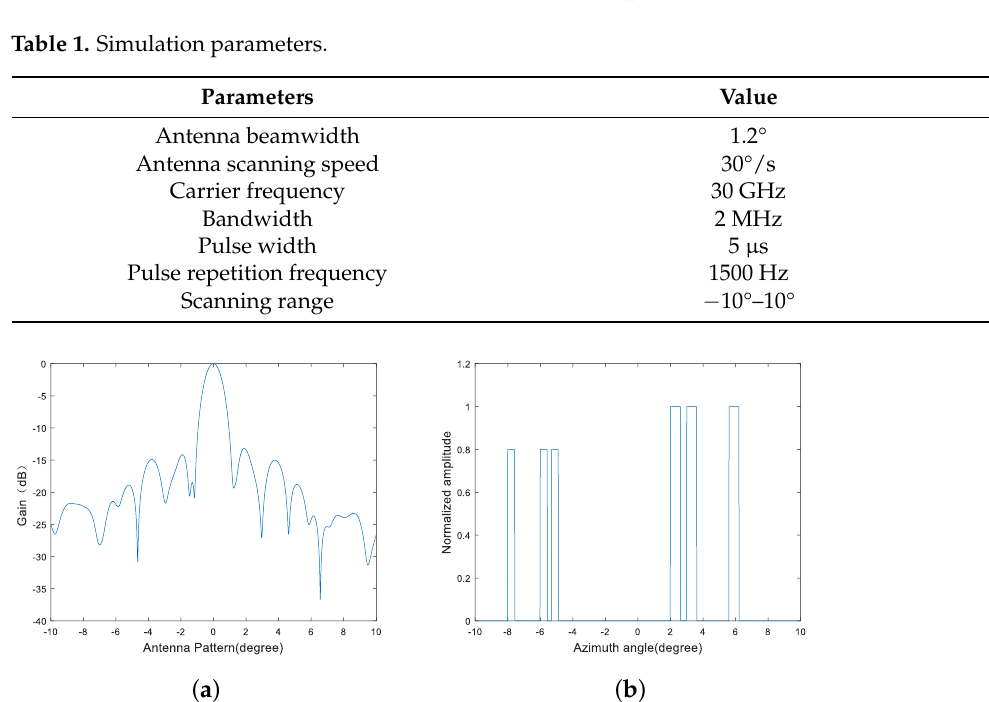
Figure 1. Antenna pattern and target scene. ( a ) Antenna pattern. ( b ) Target distribution